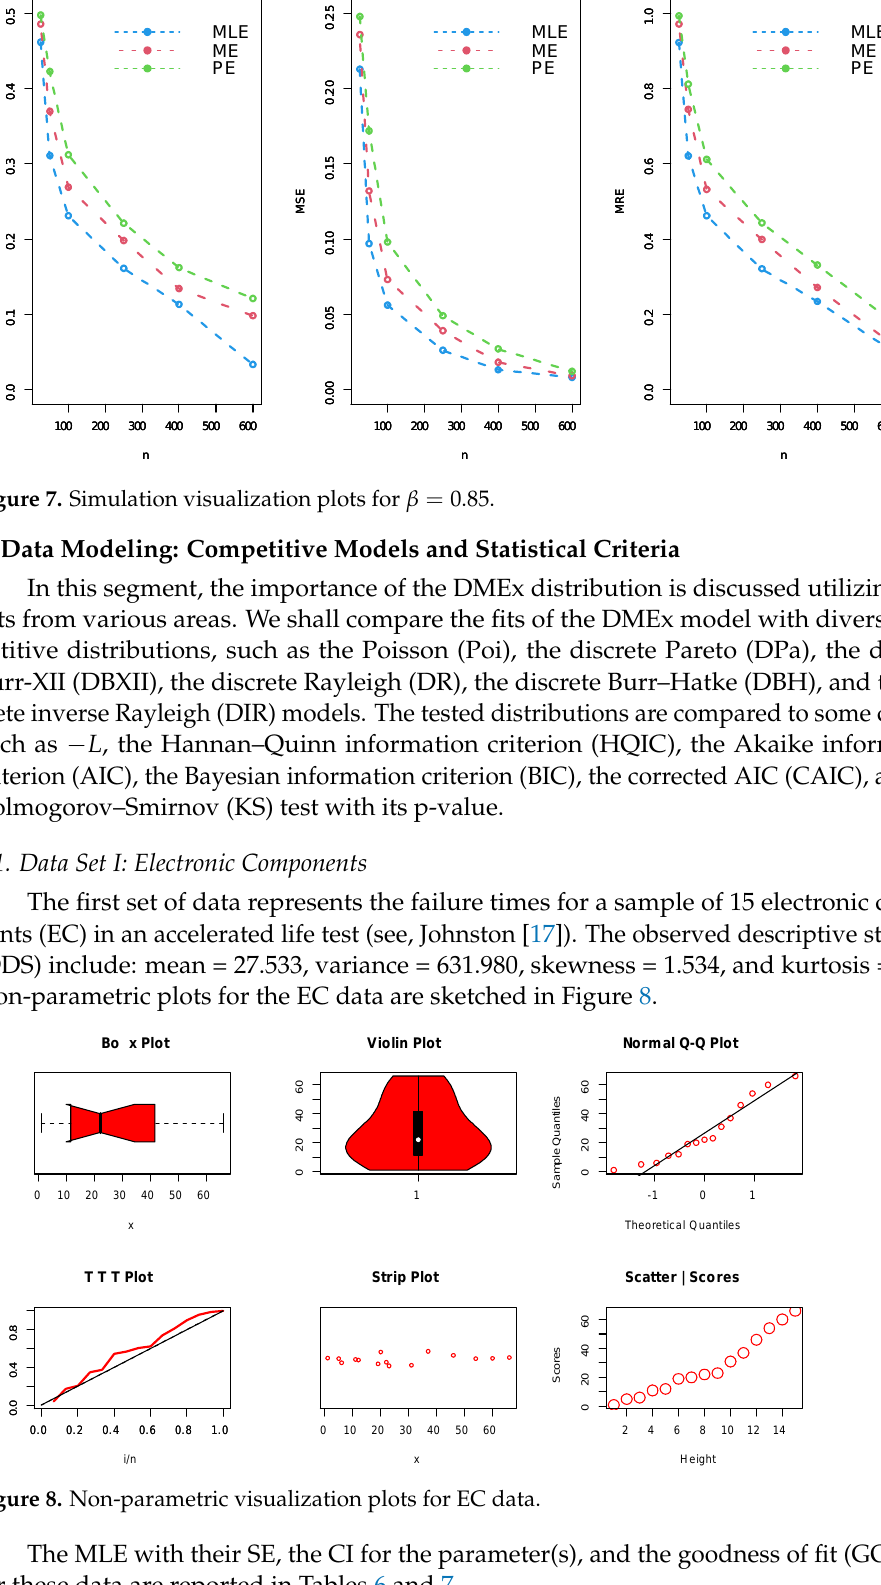
Table 5. Simulation results for (cid:12) = 0 : 85 . n